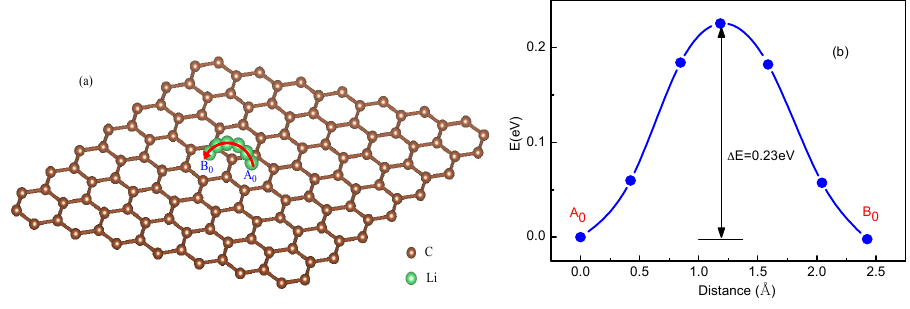
Figure 1. Schematic representation and total energy curve of a single Li ion diffusion on graphene following A 0 - B 0 path.